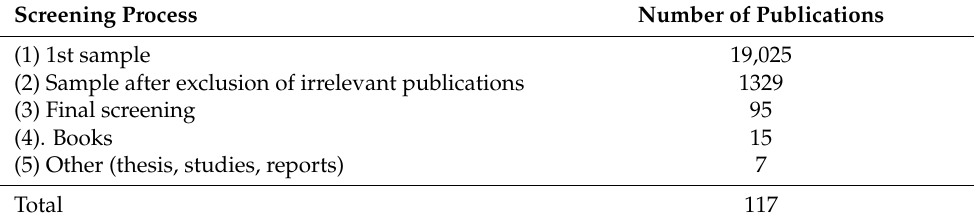
Table 3. Total screening process.